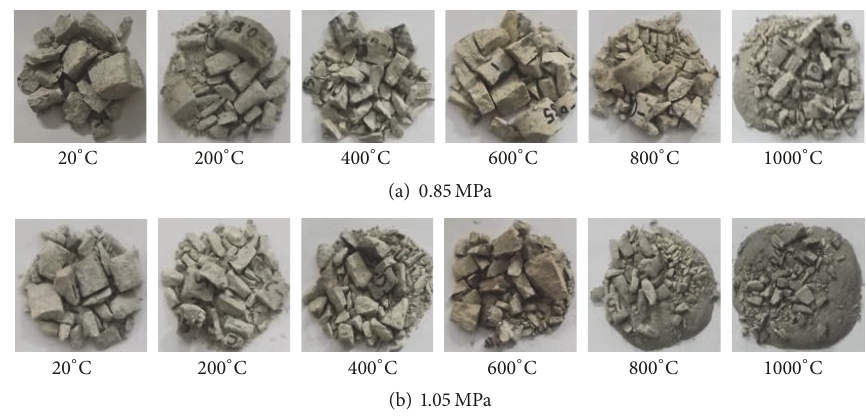
Figure 10: Dynamic compression fracture morphology of